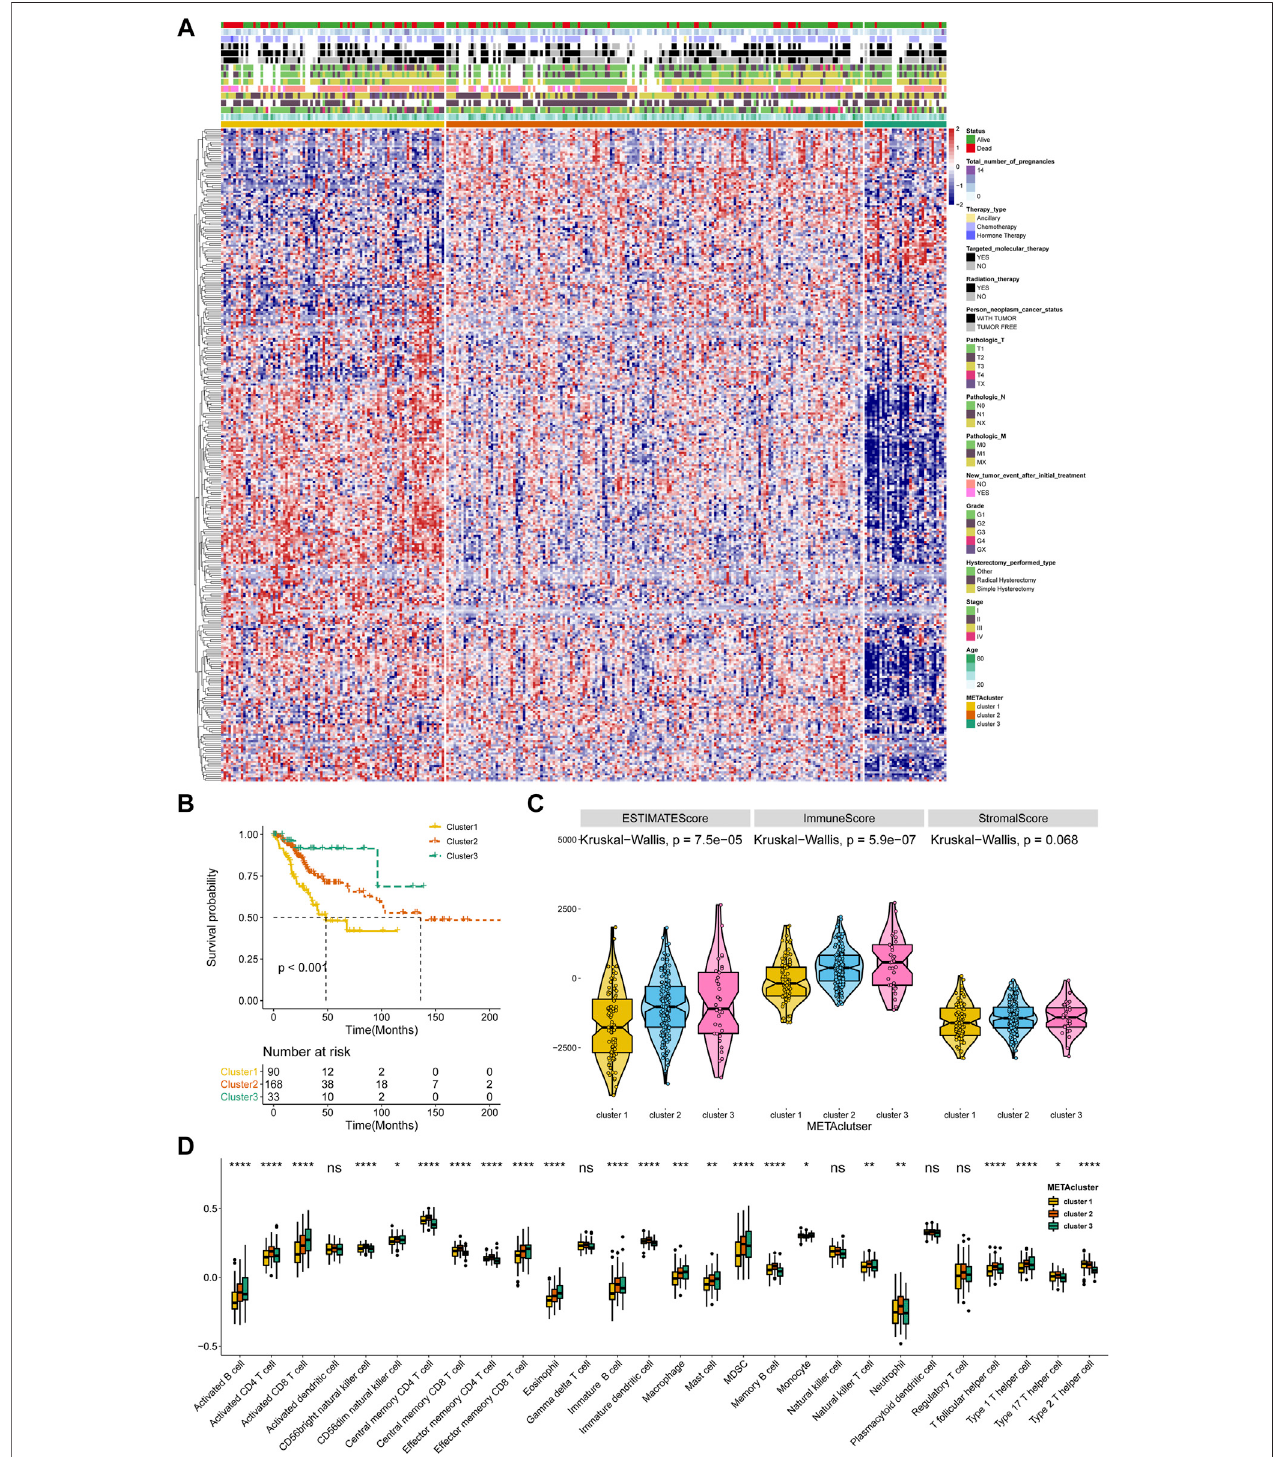
FIGURE1| Identi fi cationofthreeMETAclustersintheTCGAdataofCESC. (A) UnsupervisedclusteringofCESCpatientsbasedon315identi fi edmetabolicgenes: METAcluster 1( n (cid:1) 90), METAcluster 2( n (cid:1) 168)andMETAcluster 3( n (cid:1) 33). (B) Kaplan – MeiercurvesforsurvivaltimeofthethreeMETAclustersinCESC.Log-ranktest presented an overall p < 0.001. (C) A Violin plot showing ESTIMATE score, immune score and stromal score of the three METAclusters. (D) A Boxplot showing the abundance of immune cell populations among the three METAclusters. In each cluster, the top and bottom of the boxes represent the 75th and 25th percentiles (interquartile range), respectively, and thick line in the boxes represents median value. The statistical differences among the three METAclusters were determined using the Kruskal-Wallis test. The statistical p value was represented by asterisks (ns represents no signi fi cance; * p < 0.05; ** p < 0.01; *** p < 0.001; **** p < 0.0001).